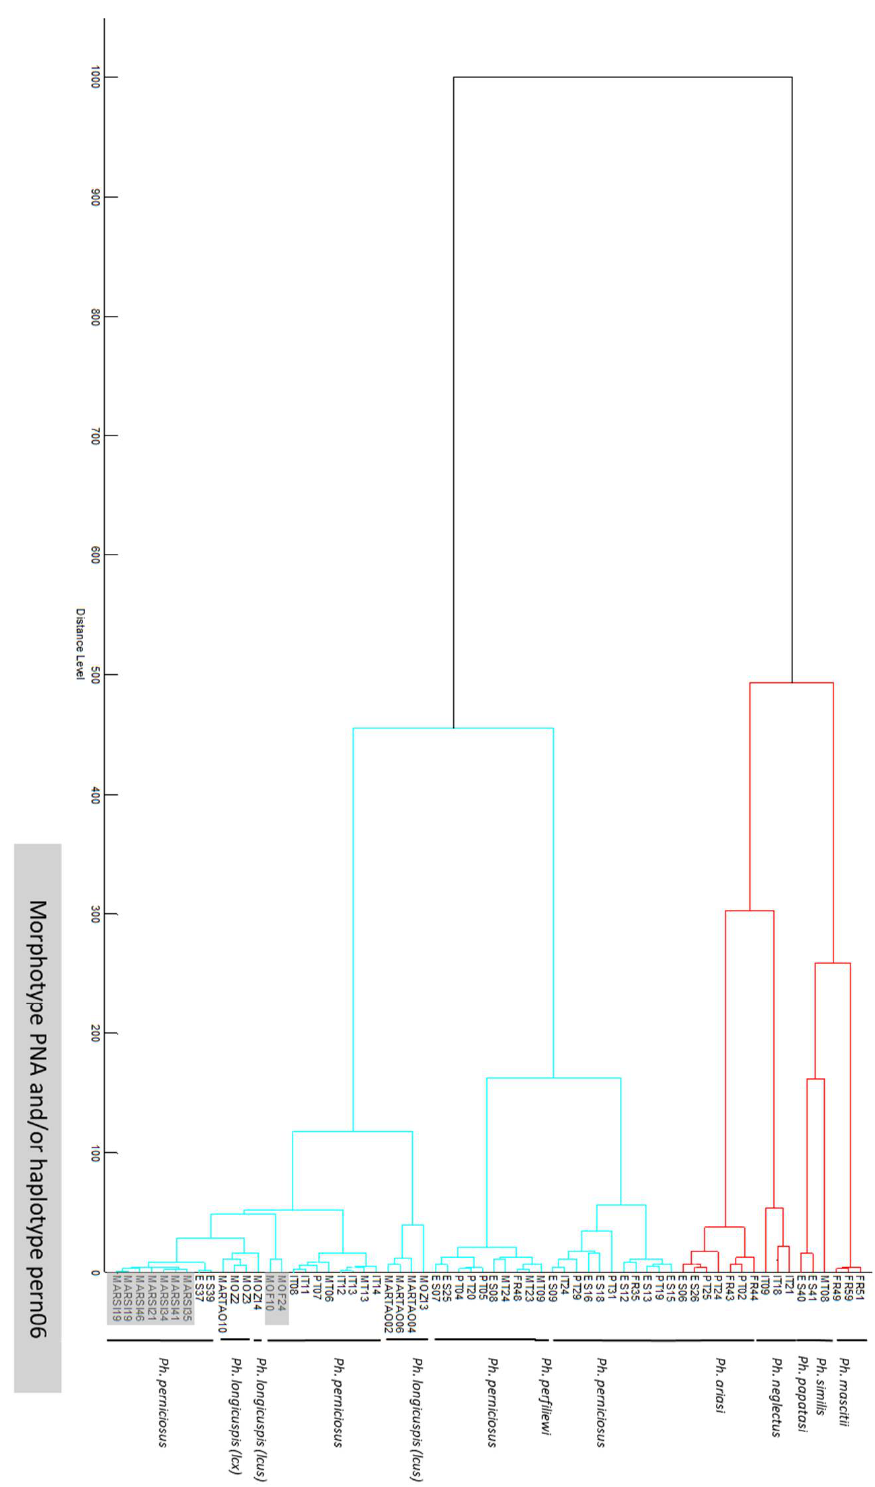
Figure 3. Hierarchical clustering dendrogram of MALDI-TOF MSP using correlation distance mea- sure and Ward algorithm. Molecular identification and PNA haplotype status (grey highlighting) is indicated.